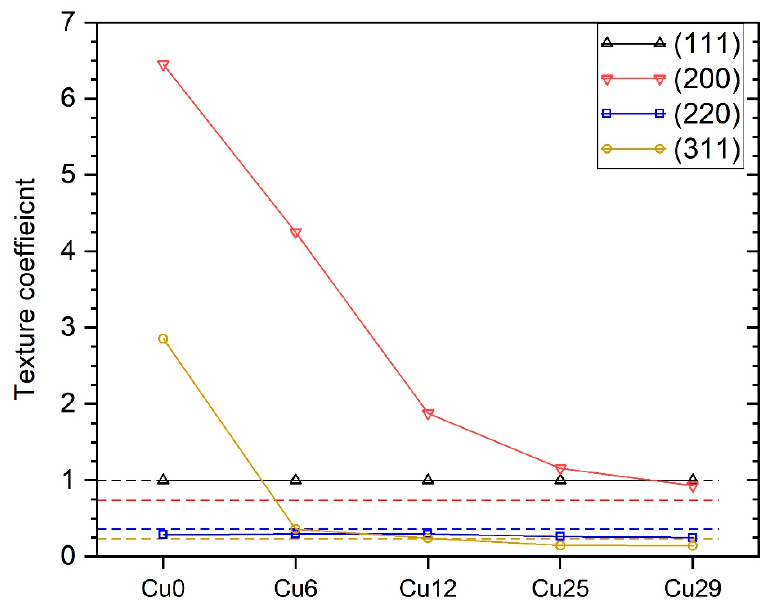
Figure 5. Texture coefficients of the ZrN-Cu coatings. The dashed lines indicate the relative intensity of ZrN diffractions in PDF card 00-035-0753.